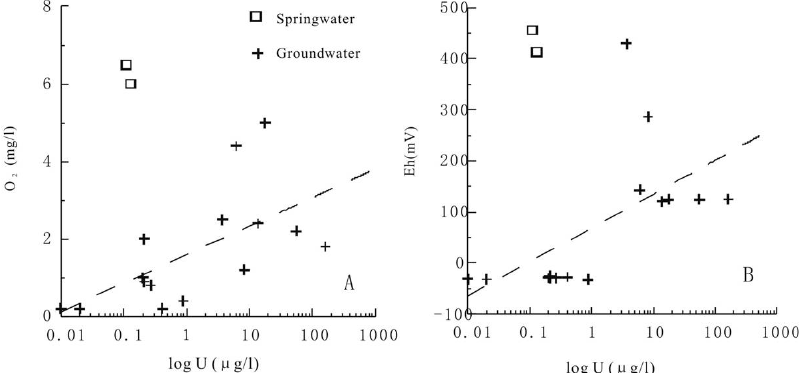
Figure 2. A plot of ( A ) U and oxygen concentrations (O 2 ); and ( B ) U concentrations and Eh values for waters from the Shihongtan U ore district. Data from Table 1.